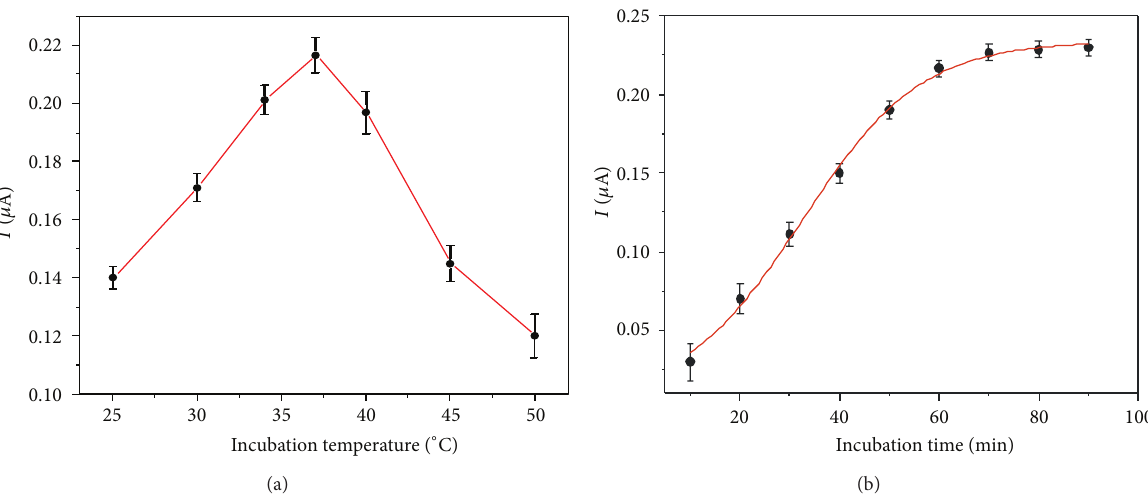
Figure 2: Effects of (a) incubation temperature and (b) incubation time on the stripping current response of Ag + from immunoreaction labels. The concentration of E. coli O157:H7 was 500